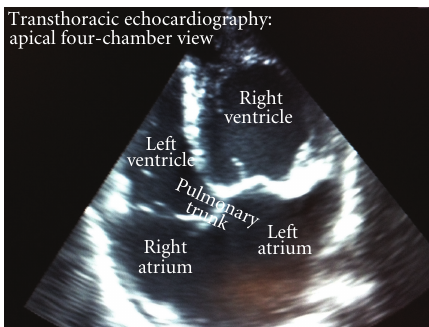
Figure 3: The transthoracical echocardiography (here apical four- chamber view) demonstrates the in situ anatomy in L-TGA. Both ventricles changed their position. The right ventricle shows dilation, hypertrophy, and trabecularisation. The right atrioventricular valve is located closer to the apex compared with the left atrioventricular